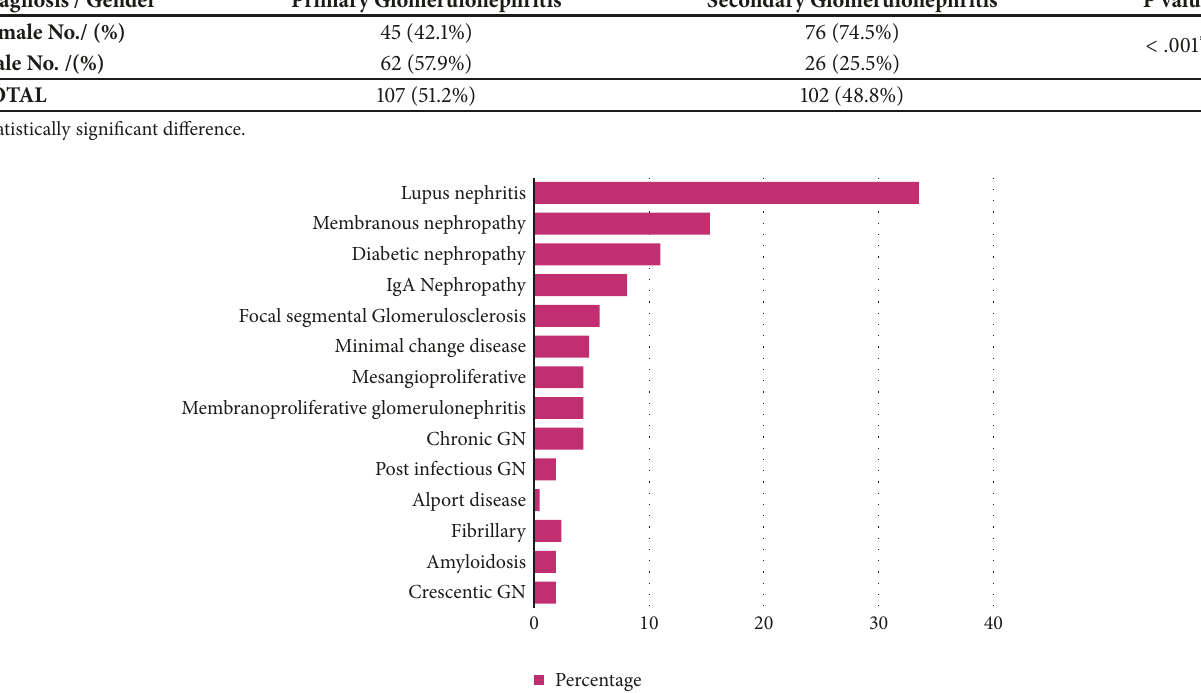
no signs of involvement by immunological or other systemic disease in these